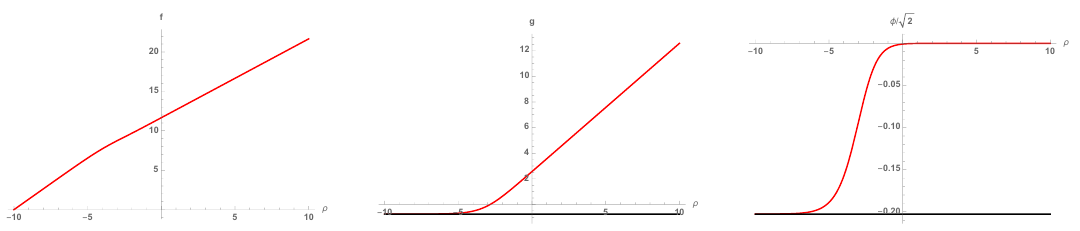
p 2 and g = 3 m . The black straight lines are